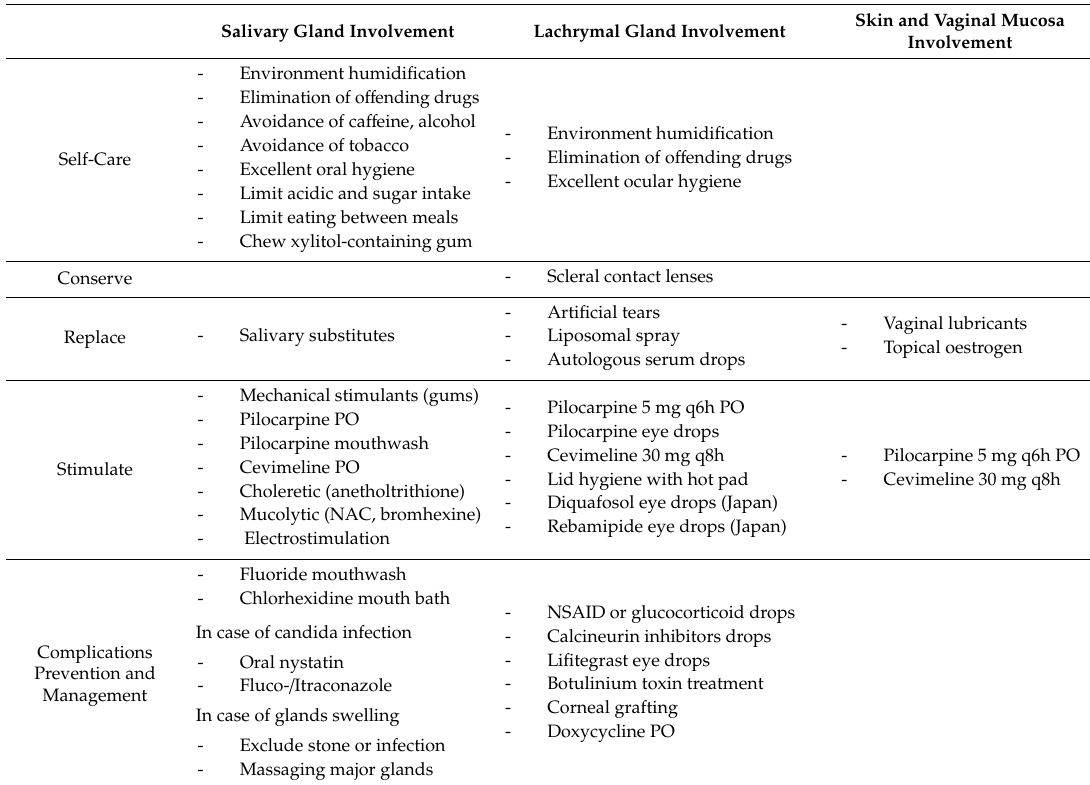
Table 5. Current treatment for sicca-related